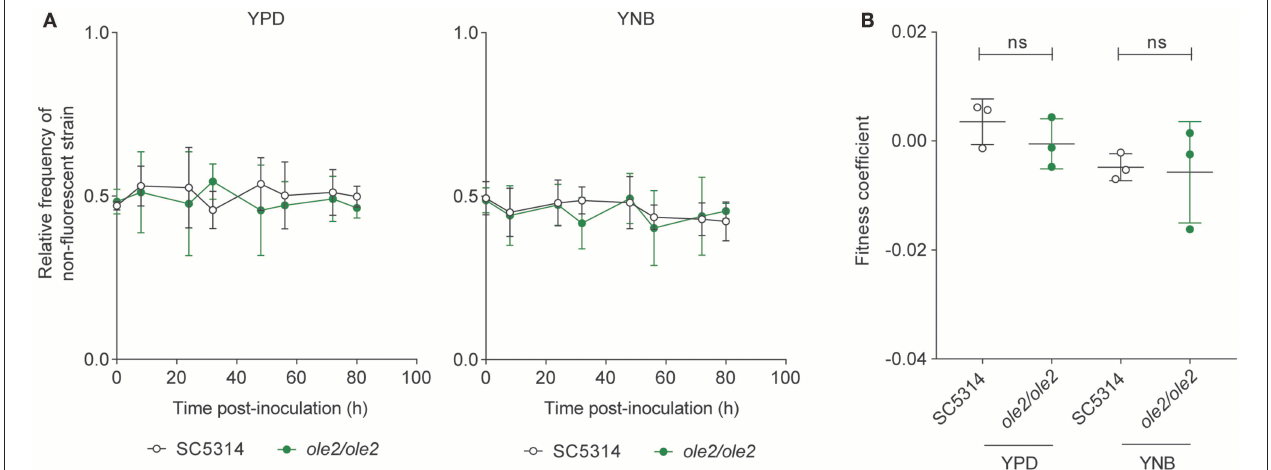
FIGURE 2 | Fungal PGE 2 is not required for the in vitro competitive fitness of C. albicans . WT C. albicans or the ole2/ole2 mutant was grown in rich (YPD) or minimal (YNB) media in competition with a fluorescently-tagged WT strain at a 1:1 ratio in serial batch cultures for 80h. (A) Relative frequencies of the WT or ole2/ole2 strain throughout the serial passages. (B) Fitness coefficients of the WT or ole2/ole2 strain, determined as outlined in Materials and Methods. Data pooled from 3 independent experiments. Mean ± s.d. ns, not significant. Student’s t